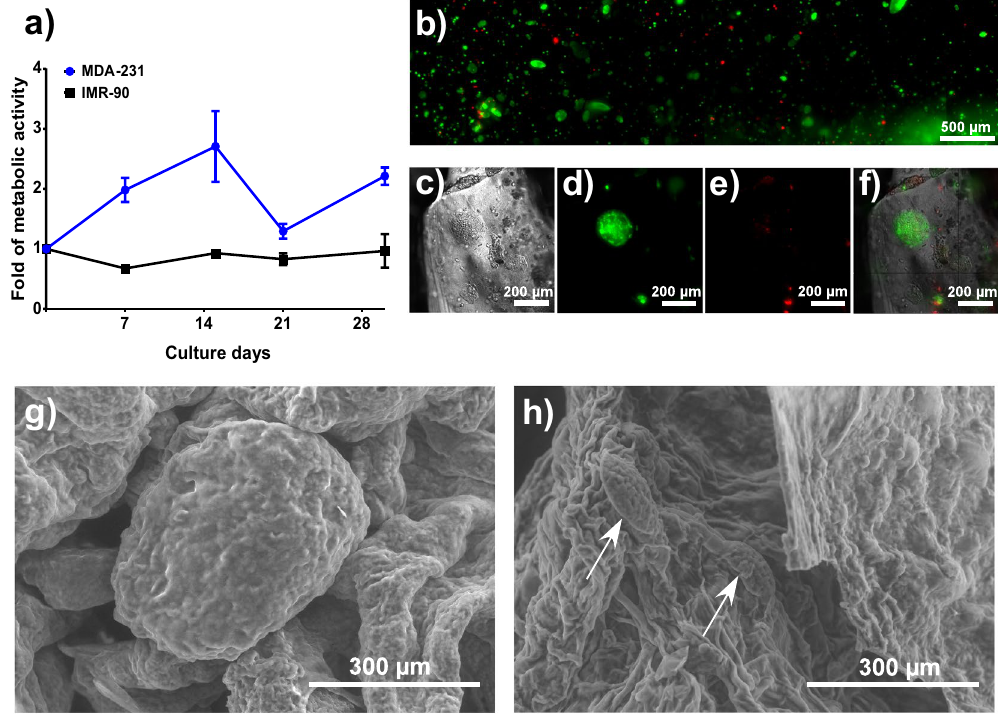
Figure 4. Cell viability and MCTS development. ( a ) Cell viability of MDA-MB-231-GFP and mCherry-IMR-90 during 30 days of culture within the hydrogel. ( b ) LIVE/DEAD assay of unlabeled MDA-MB-231 cells after 21 days of culture with a representative full view ( b ) across the width of the entire sample. ( c ) Magnified bright field image of a representative MCTS, ( d ) fluorescence image of live cells stained with the LIVE/DEAD assay, ( e ) fluorescence image of dead cells stained with the LIVE/DEAD assay, ( f ) merged bright field and fluorescent LIVE/DEAD assay images, ( g – h ) SEM images of MDA-MB-231 MCTS within the gel after 21 days of culture showing ( g ) medium and ( h ) small MCTS (indicated with pointed arrows) under a magnification of 150x. Results showed in mean ± SD, n =